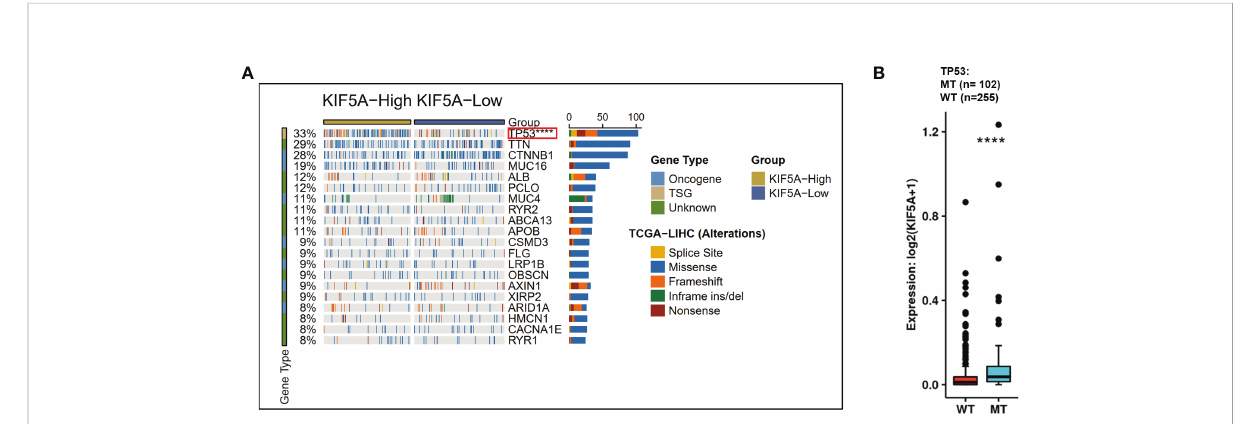
FIGURE 6 Correlations of KIF5A expression level with gene mutation. (A) KIF5A-Related Mutational Landscape in LIHC. (B) KIF5A expression level was positively correlated with the mutation frequency of TP53 . **** p <